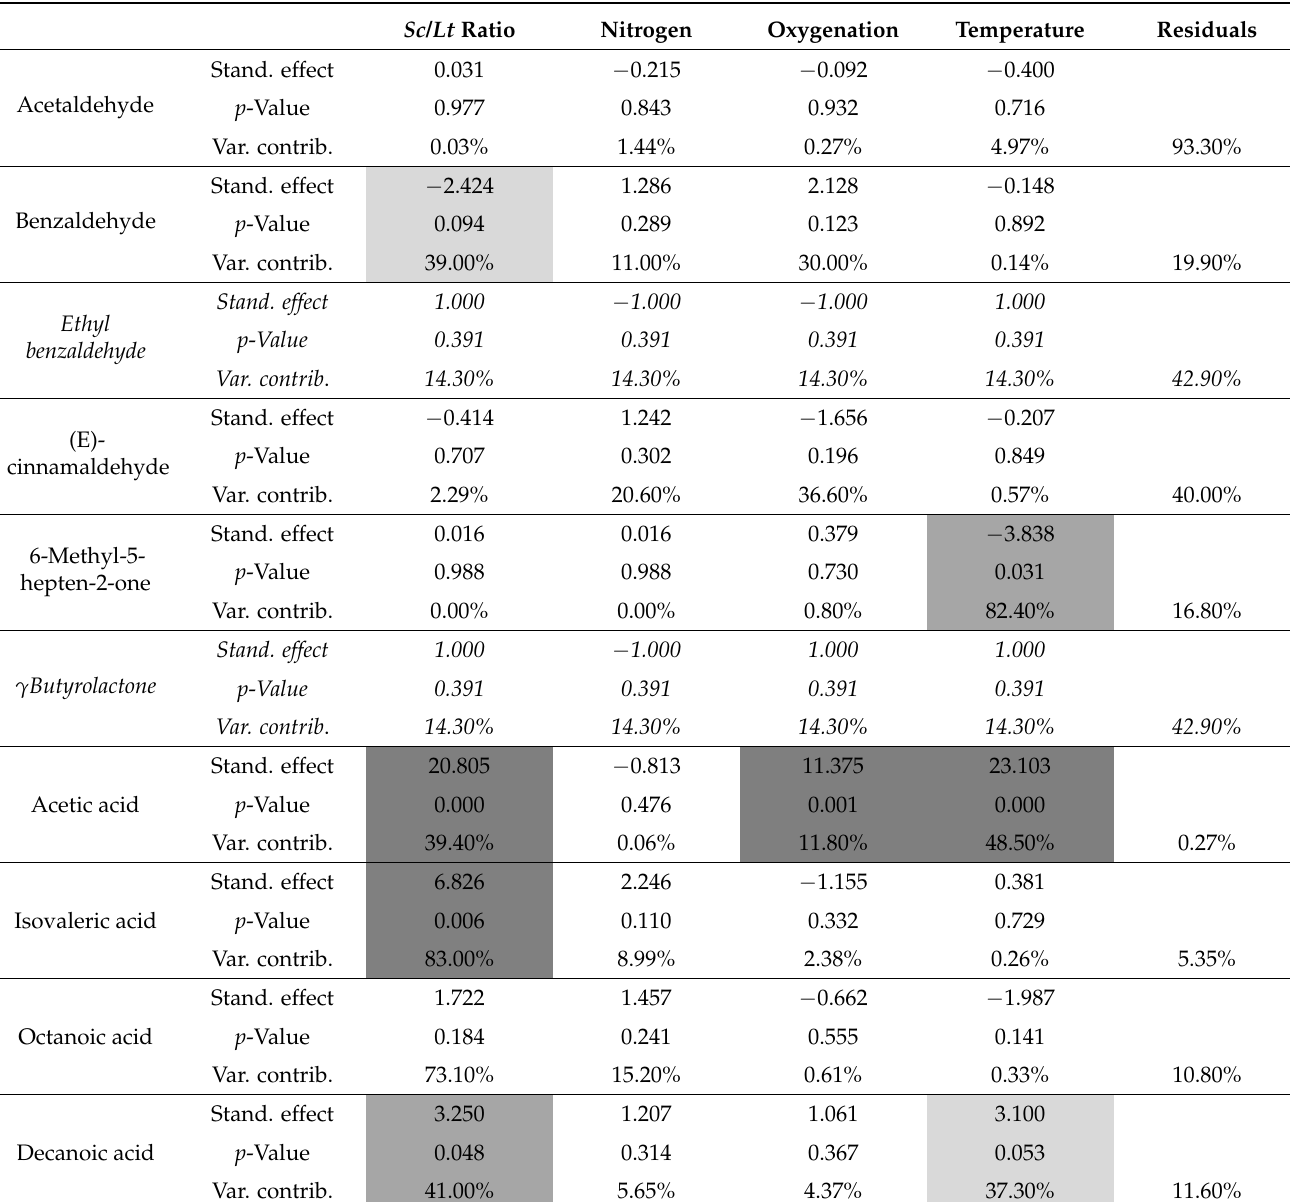
Table 7. Impact of fermentation parameters on the production of different volatile compounds (aldehydes, ketones,